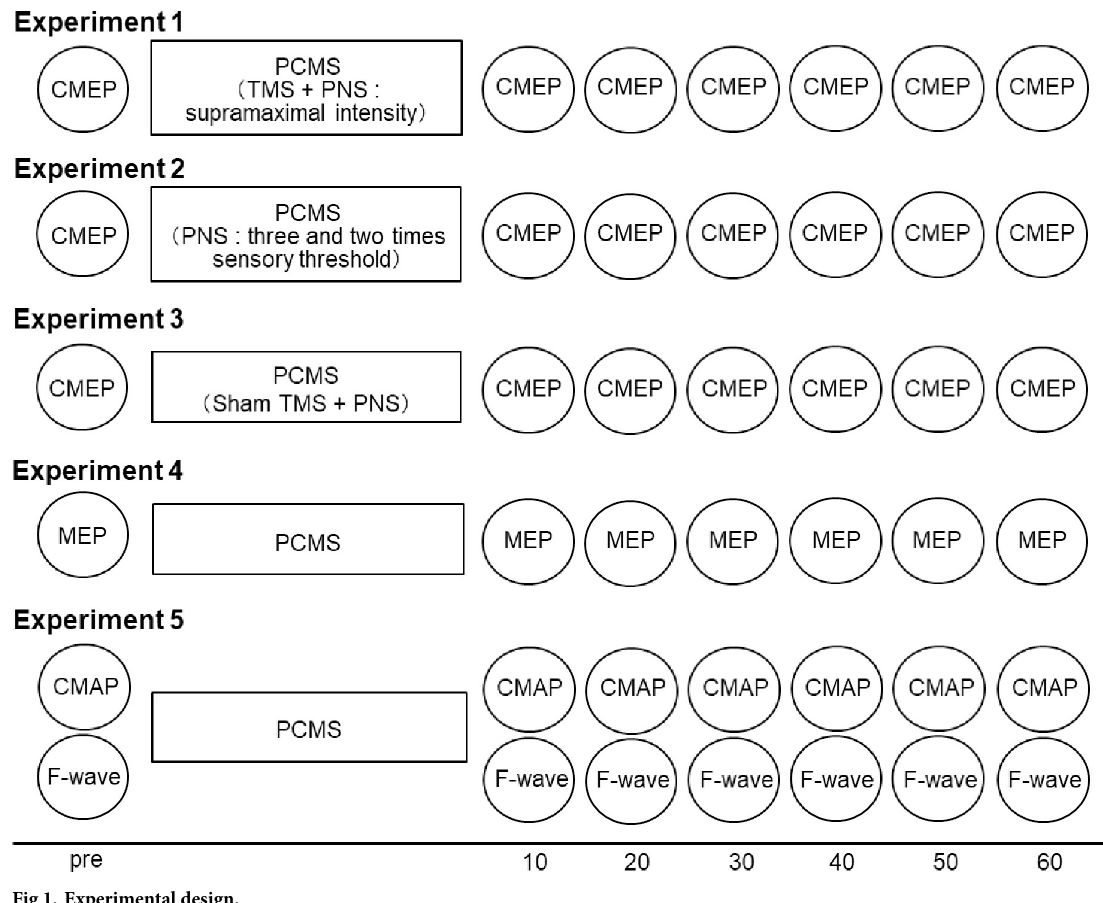
Fig 1. Experimental